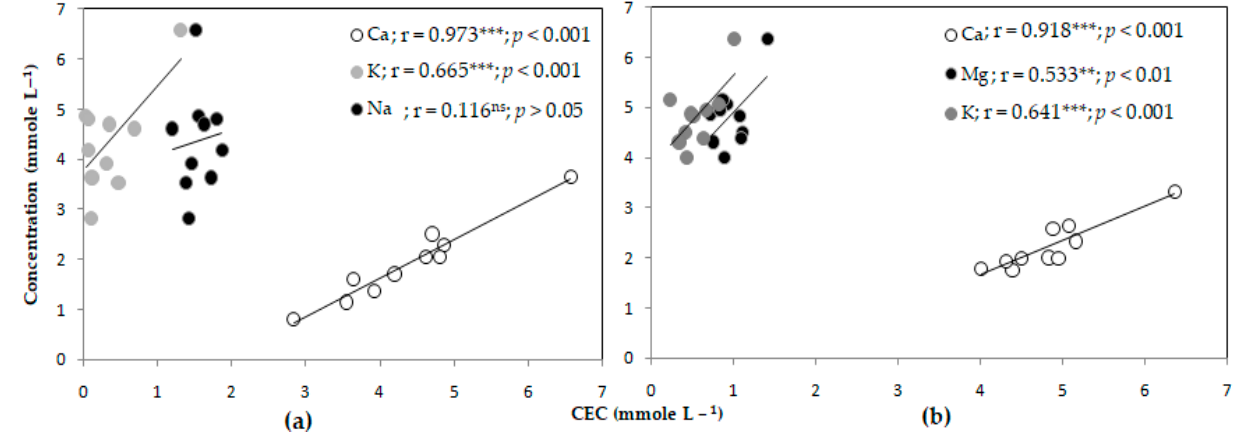
Figure 2. Linear regressions showing the relationship between calcium (Ca 2+ ), magnesium (Mg 2+ ), potassium (K + ), and sodium (Na + ) concentrations for cation exchange capacity (CEC) in soils irrigated with ( a ) groundwater and ( b ) treated wastewater. Cation concentrations and CEC are averaged across all depths. **, *** Significant at p < 0.01, and p < 0.001, respectively. ns = Not significant.